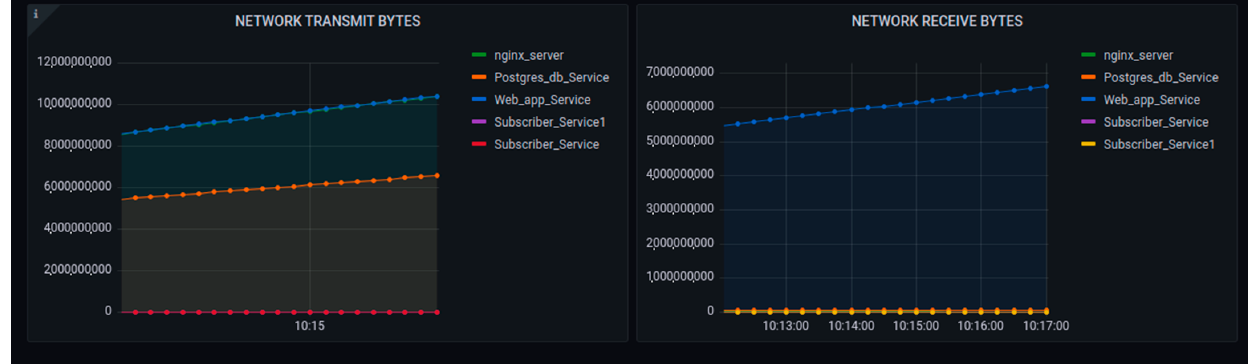
Figure 22. Performance of the platform after scaling up the requests to 1,000,000 network data transmissions.